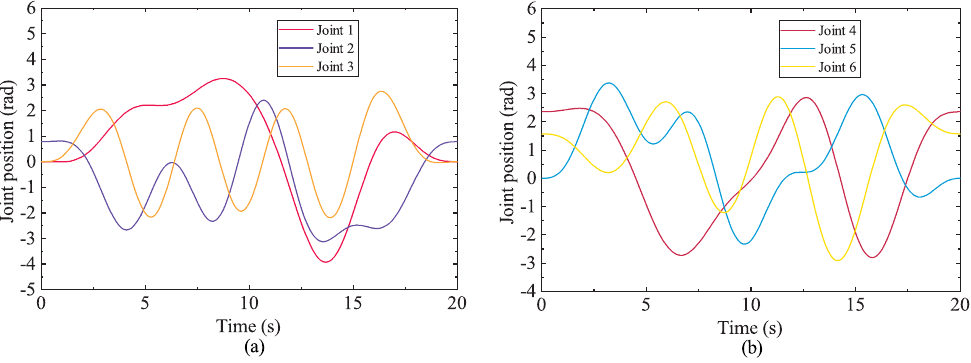
Figure 5. Robot excitation trajectory. ( a ) Excitation trajectories of joints 1, 2, and 3. ( b ) Excitation trajectories of joints 4, 5, and 6.